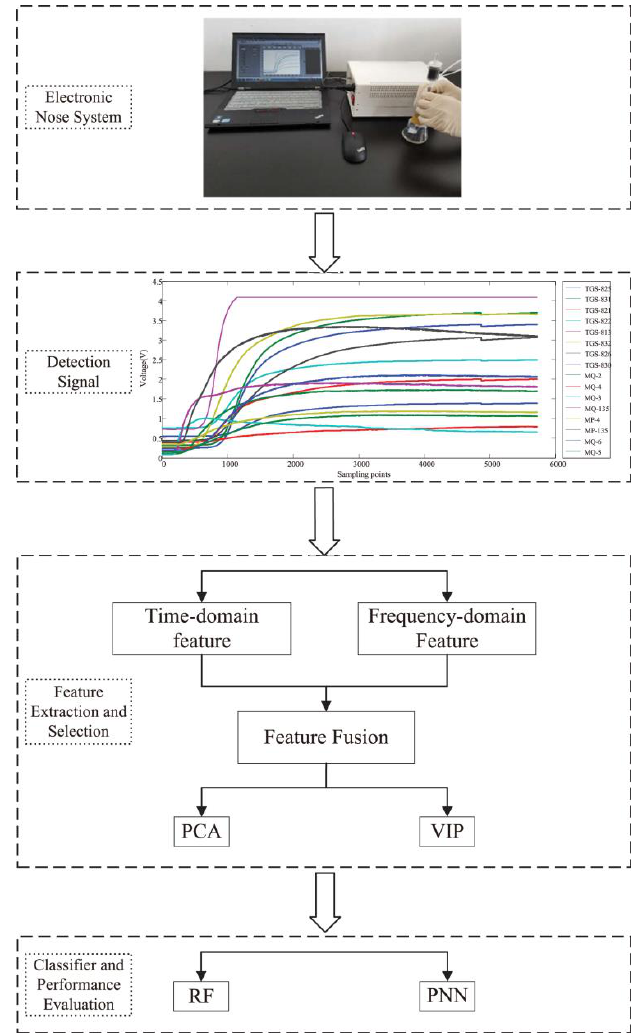
Figure 1. Flow chart of odor fingerprint analysis.